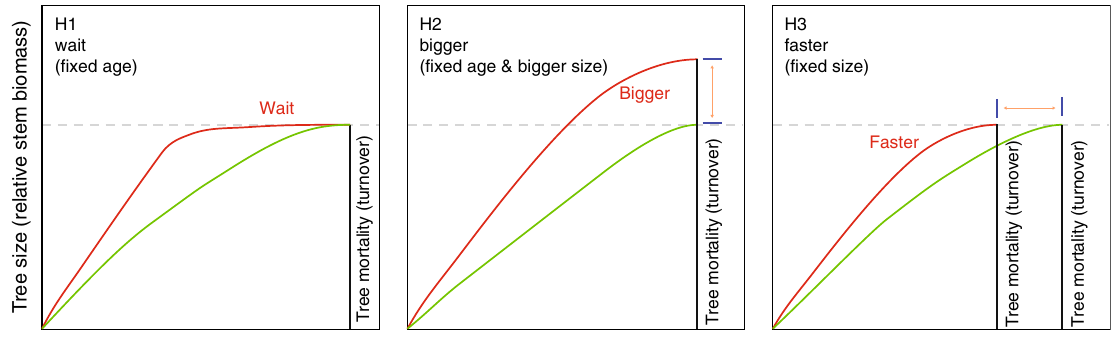
Fig. 1 Conceptual diagram of tree growth under global warming. Three alternative hypotheses of how the relationship between the longevity (age) and growth rate (size) of trees may change under predicted global warming (red lines). H1 shows faster initial growth rates that are, however, not sustained until tree death ( fi xed-age hypothesis). H2 shows faster growth rates throughout the entire lifetime that is, however, not affected (bigger hypothesis). H3 shows faster growth rates together with a shorter lifespan ( fi